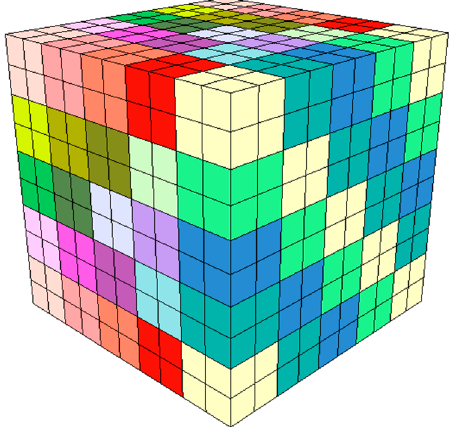
n . Figure 9. The subsoil FE model; 125 distinct sub-blocks of E modulus, n E = 125. E = 0.1083 m and standard δ 125 = 0.1165 m 125